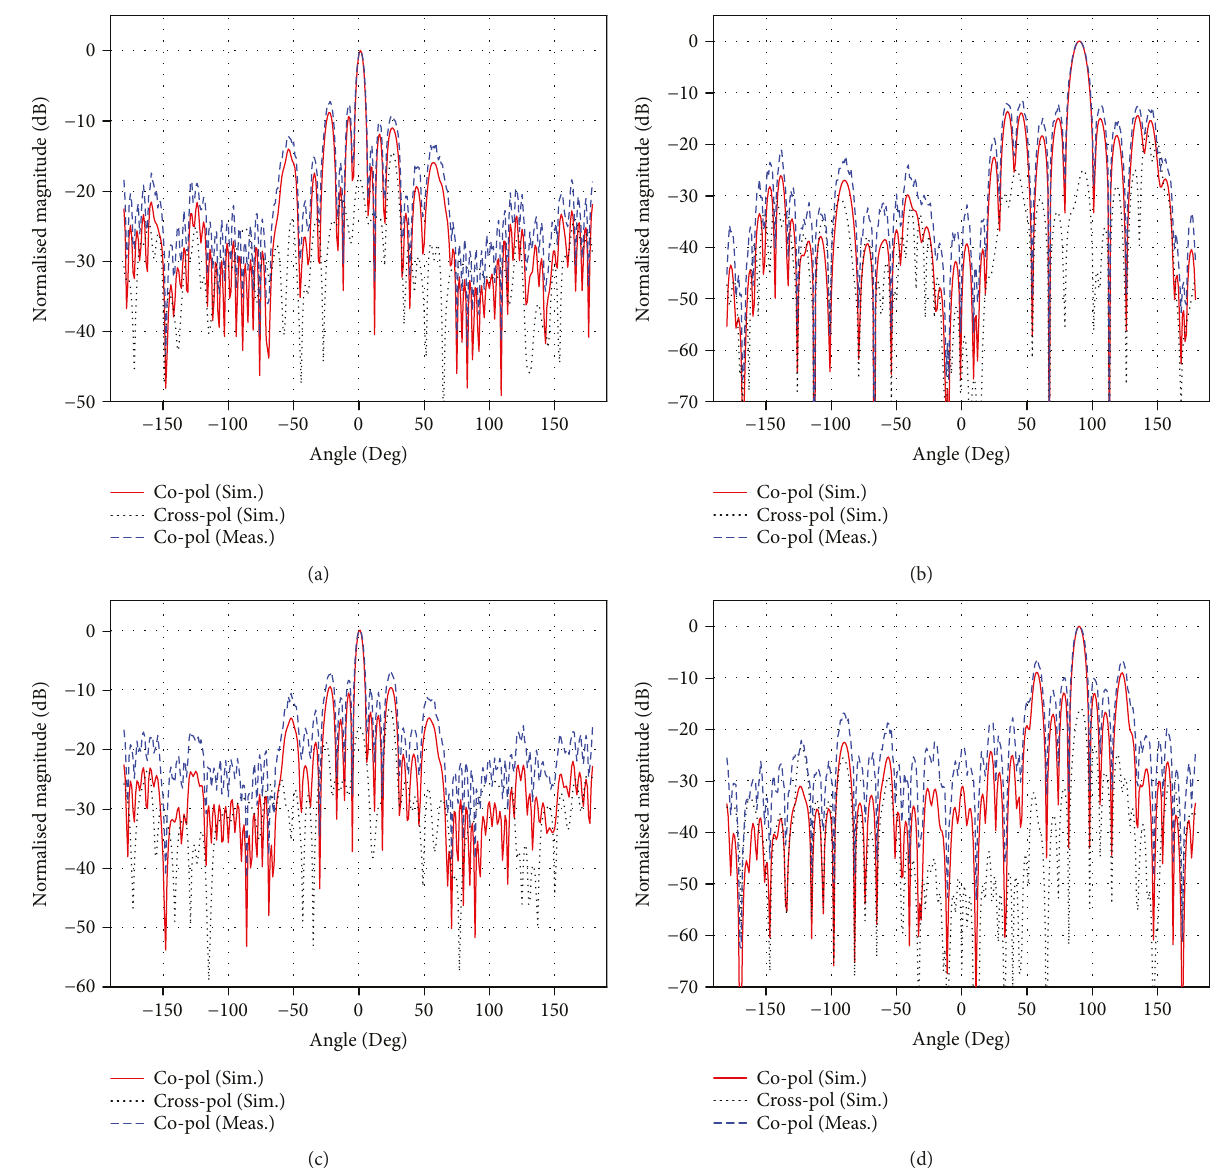
Figure 10: Measured Co-pol radiation patterns of the 1 × 4 linear Vivaldi antenna array. (a) E-plane 28 GHz. (b) H-plane 28 GHz. (c) E-plane 38GHz. (d) H-plane